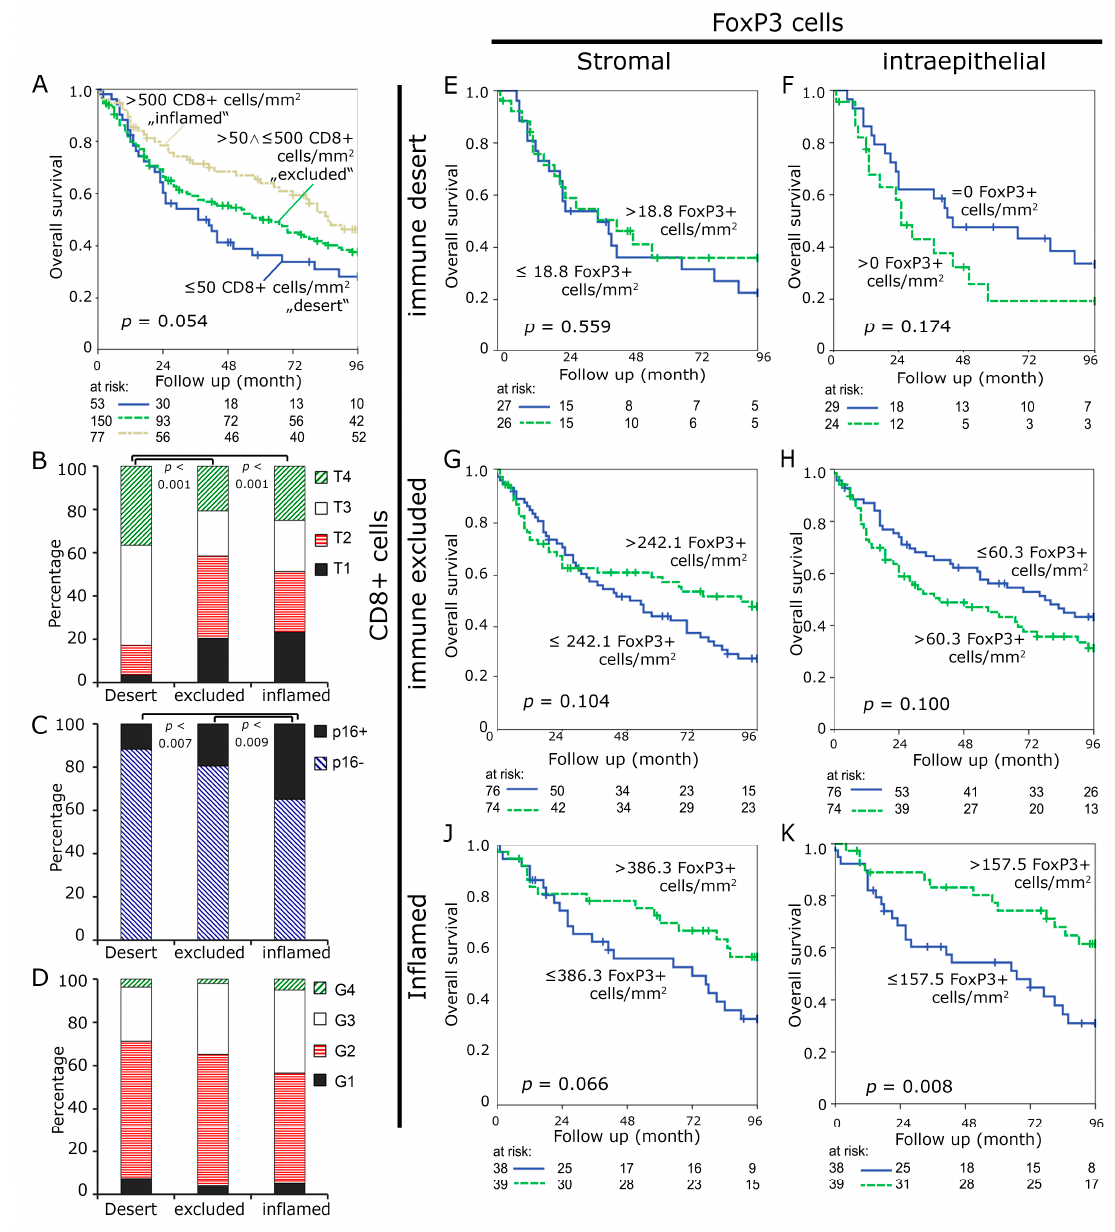
Figure 2. Subgroups “immune desert”, “immune excluded” and “inflamed”. “Immune desert” was defined as having ≤ 50 CD8 + cells / mm 2 in the stromal compartment, “immune excluded” ≤ 500 CD8 + cells in the intraepithelial and > 50 in the stromal compartment and “inflamed” having > 500 cells in the intraepithelial compartment. Kaplan Meier plots for overall survival in these groups ( A ) Tumor size ( B ) p16 staining ( C ) and tumor grade ( D ) were compared. Kaplan-Meier plots for the FoxP3 + cell densities in the stromal and intraepithelial compartment in the “immune desert” group ( E , F ), in the “immune excluded” group ( G , H ), and the “inflamed” group ( J , K ) Cut-o ff values were median FoxP3 +